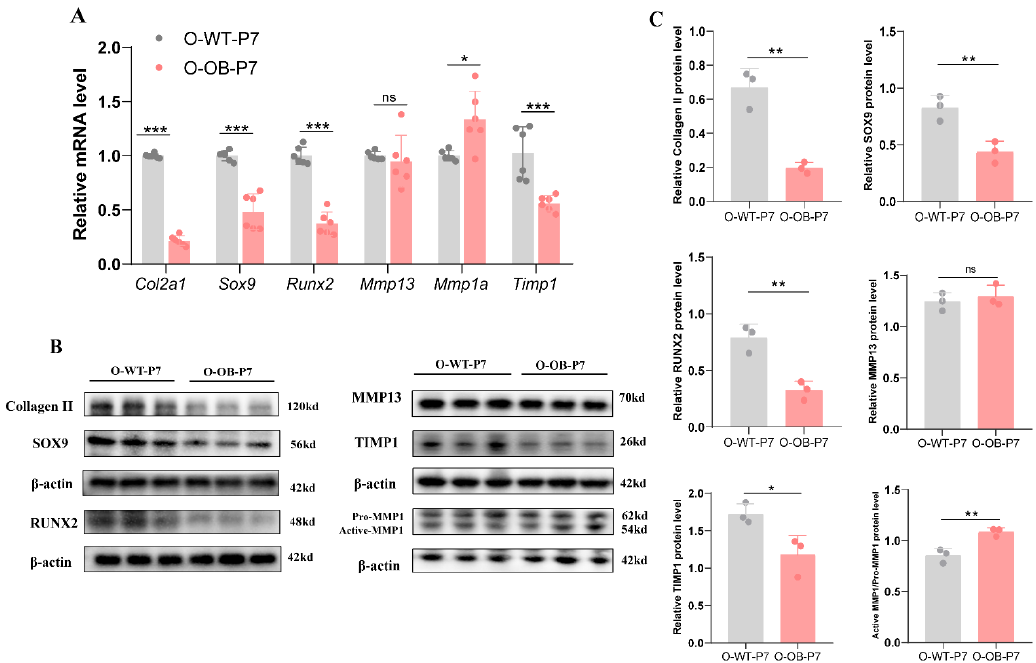
Figure 3. Key indicators expression of knee cartilage in 7 ‐ day male mice offspring of control and obese groups. ( A ) Relative mRNA, ( B ) representative western blot bands, and ( C ) statistical results of knee cartilage 7 ‐ day male mice offspring in the control group versus obese group. O ‐ WT ‐ P7: offspring 7 ‐ day male mice from the control mothers. O ‐ OB ‐ P7: offspring 7 ‐ day male mice from the obese mothers. ( A ) n = 6 represents six mice in each group from at least three litters of different mothers. ( B ) n = 6, each band represents the expression of cartilage tissue proteins in two mice from at least three litters of different mothers. Results are expressed as mean ± SD. ns not significant, * p < 0.05,** p < 0.01, and *** p < 0.001.